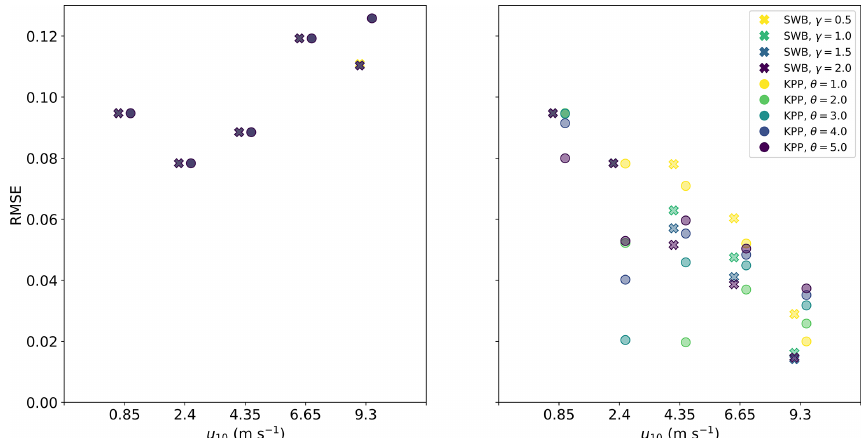
Figure 5. RMSE between field measurements and modeled concentration profiles for M-0 models with KPP and SWB diffusion under different wind conditions. All KPP diffusion simulations were with z 0 according to Eq.